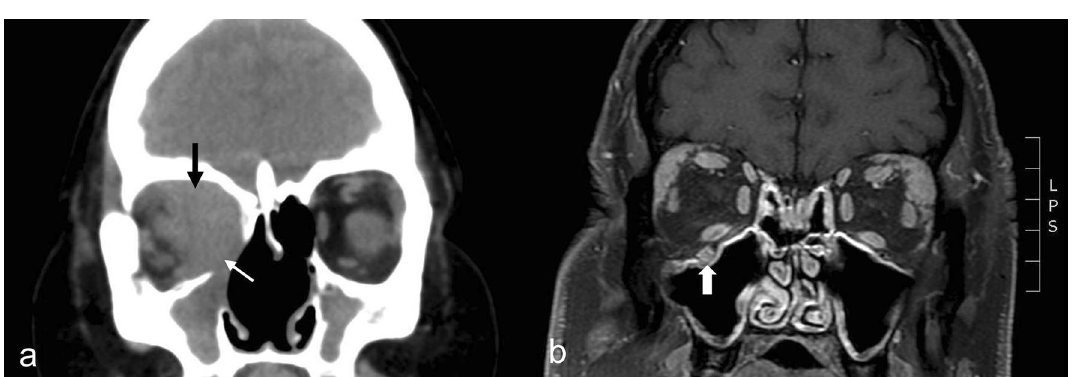
Figure 3. Representative images of granulomatosis with polyangiitis (GPA) and IgG4-related ophthalmic disease (IgG4-ROD). ( A ) Coronal unenhanced computed tomography scan shows diffuse, homogeneous, retrobulbar mass affecting extraconal and intraconal space of the right orbit (black arrow). Note nasal septal destruction and the contiguous sinus involvement with orbital wall and orbital floor destruction, characteristic of GPA (white arrow). The radiologic diagnosis was GPA, compatible with the clinical diagnosis. ( B ) Asymmetric, bilateral lacrimal gland enlargement is seen on coronal, fat suppressed T1-weighted contrast- enhanced magnetic resonance image. Right infraorbital nerve enlargement (white arrow) is reported as a more specific finding of IgG4-ROD, and the radiologic diagnosis was IgG4-ROD.